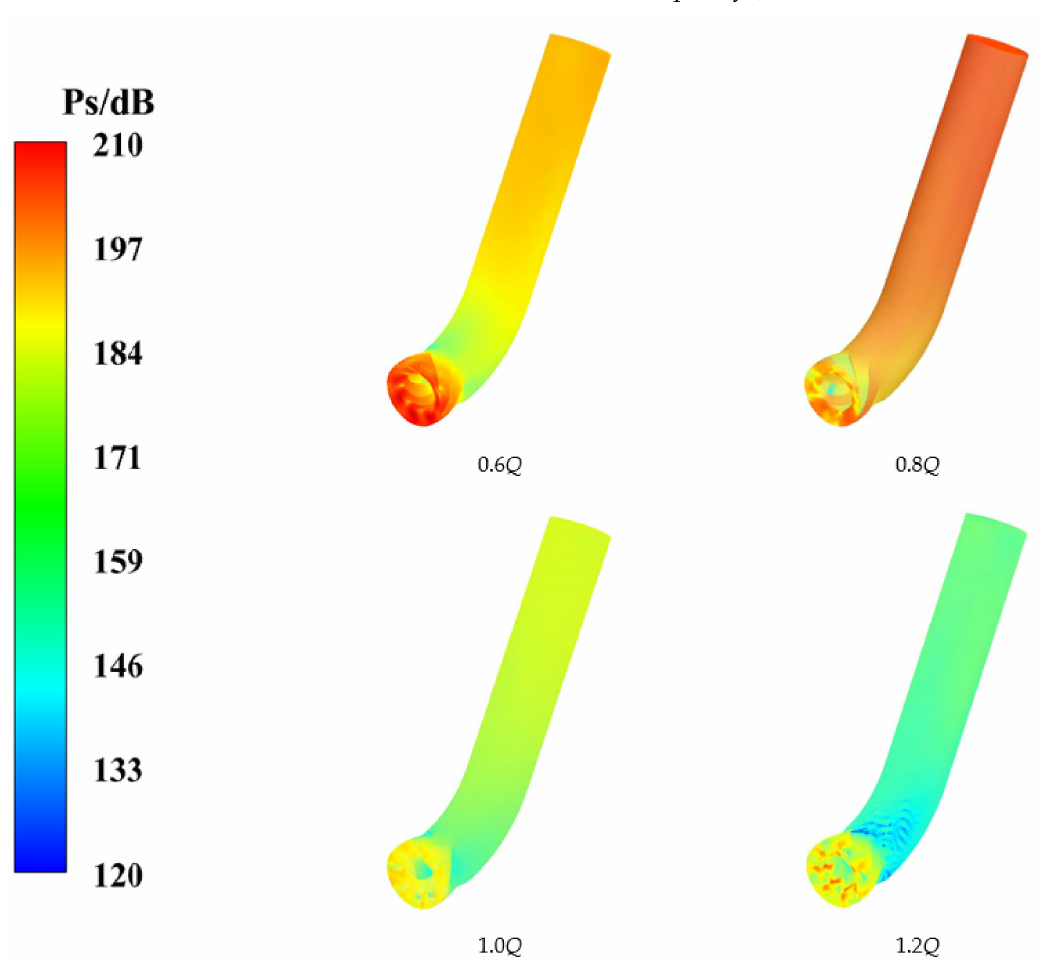
Figure 12. Sound pressure level distribution of guide vane and outlet area under different flow rate